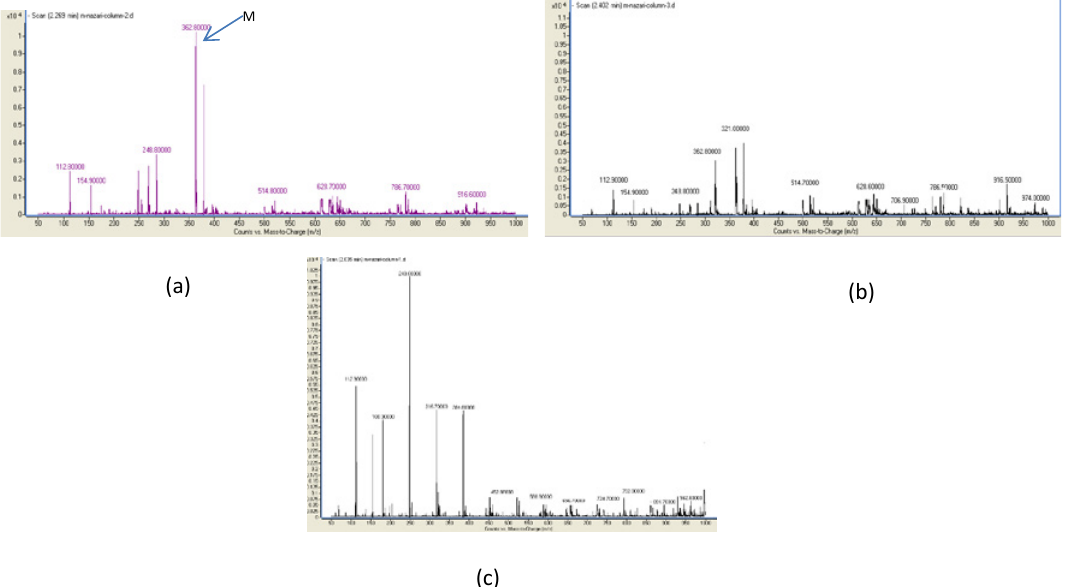
Fig 6. (a) LC-mass spectrometry test of SDBS in the initial sample of photocatalytic system (b) LC-mass spectrometry test of SDBS in final sample of photocatalytic system (c) LC-mass spectrometry test of SDBS in final sample of electrocoagulation/flotation system